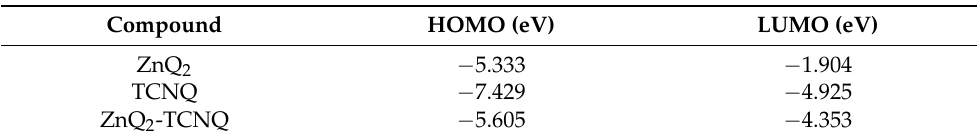
Table 1. Energy values of orbitals HOMO and LUMO for compound ZnQ 2 -TCNQ and their precursor compounds from